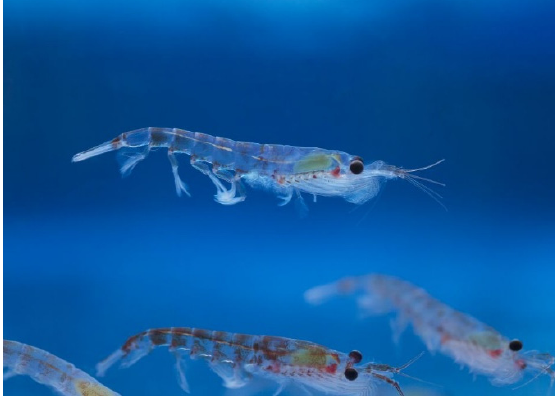
Figure 22 . Specimens of Euphausia superba . © Brett Wilks; http://www.antarctica.gov.au/. Figure 22. Specimens of Euphausia superba . © Brett Wilks; http: // www.antarctica.gov.au /